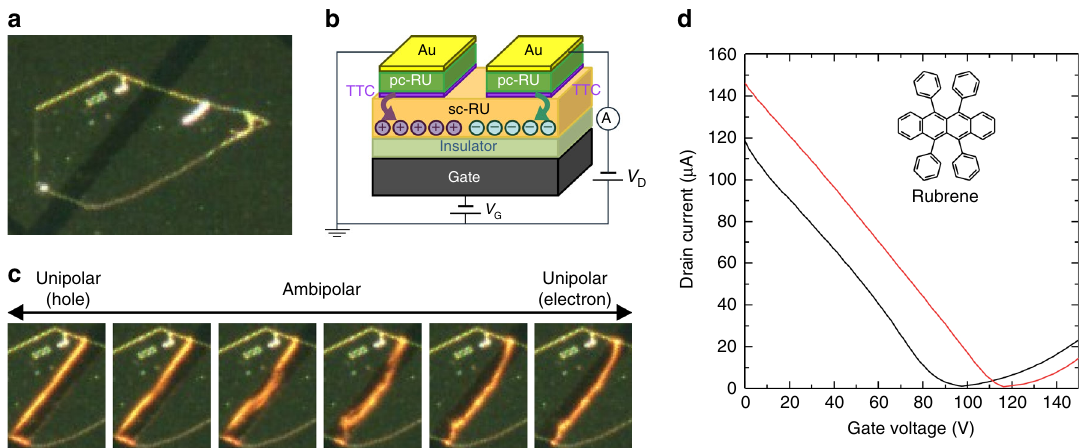
Fig. 5 Light emission from a FET of a rubrene single crystal. a An optical micrograph. b A schematic illustration of a rubrene single crystal (sc-RU) FET. c Change in position of light-emitting zone with respect to the gate voltage ( V G ), indicating ambipolar light emission. d Transfer characteristics of the sc-Ru FET before (black) and after (red) air exposure of 2 h. The drain voltage V D was